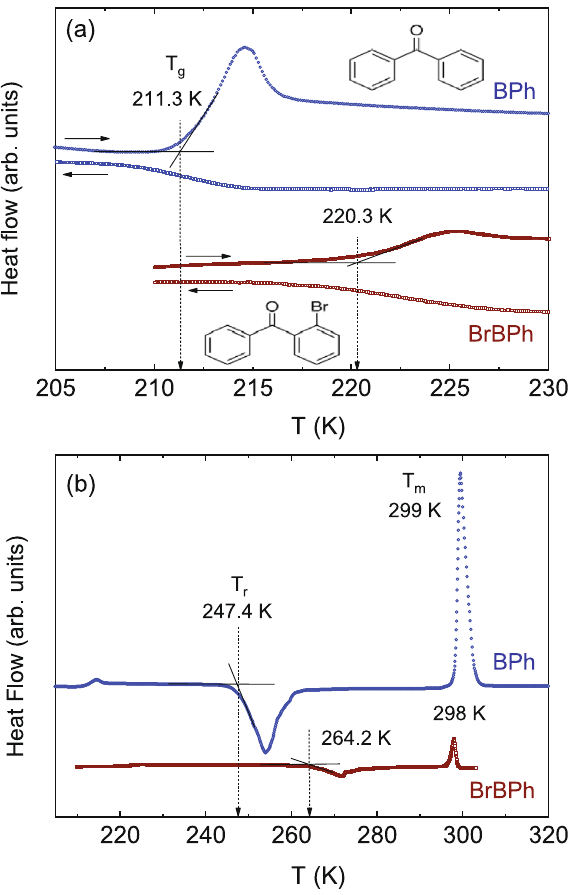
Figure 1. Ambient-pressure DSC thermograms (markers) of amorphous benzophenone (BPh) and ortho- bromobenzophenone (BrBPh) measured near the glass transition temperature ( a ) and upon heating to the melting point of the crystalline phase ( b ), normalized to sample mass. In ( a ), both cooling and heating ramps are shown, and the molecular structures of both compounds are displayed. In both panels an offset is introduced between the two traces for better clarity. Thin continuous lines indicate the determinations of the onset glass transition temperatures ( T g ) in ( a ) and the onset recrystallization temperatures ( T r ) in ( b ). Both are indicated by dashed vertical arrows. In ( b ), the melting points (peaks) are also